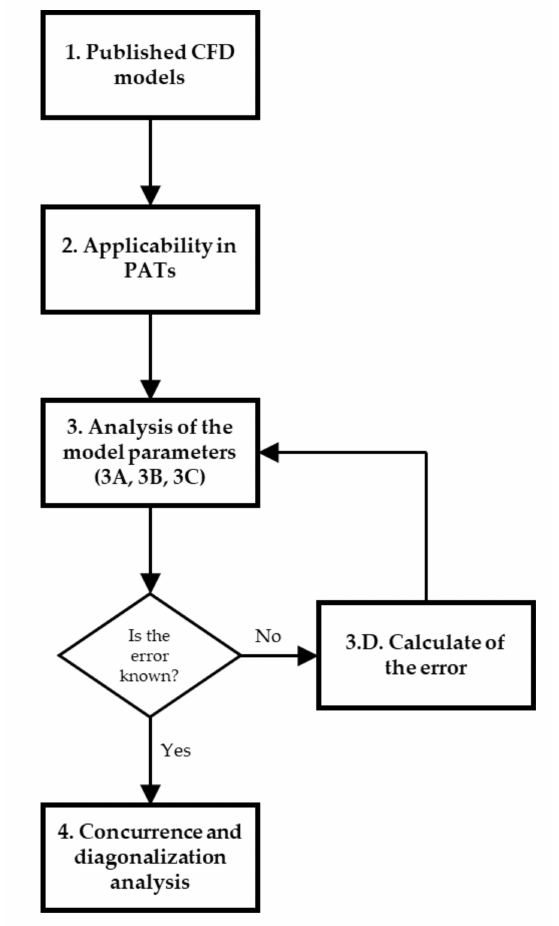
Figure 2. Methodology